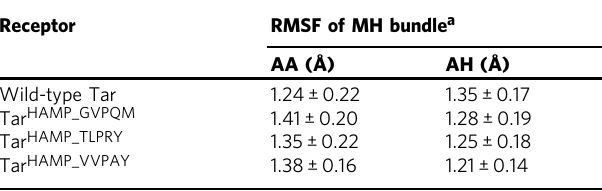
Table 2 Structural dynamics of the MH bundle in the AA and AH states of the wild-type and mutant Tar dimer Receptor